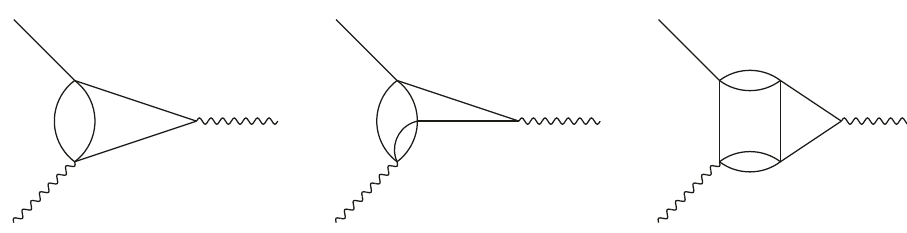
Figure 15. Topologies for (cid:25) 0 (cid:13) (cid:3) (cid:13) (cid:3) . The solid lines all refer to pion states, but the analytic ! properties of these Feynman diagrams are again indicative of the general analytic